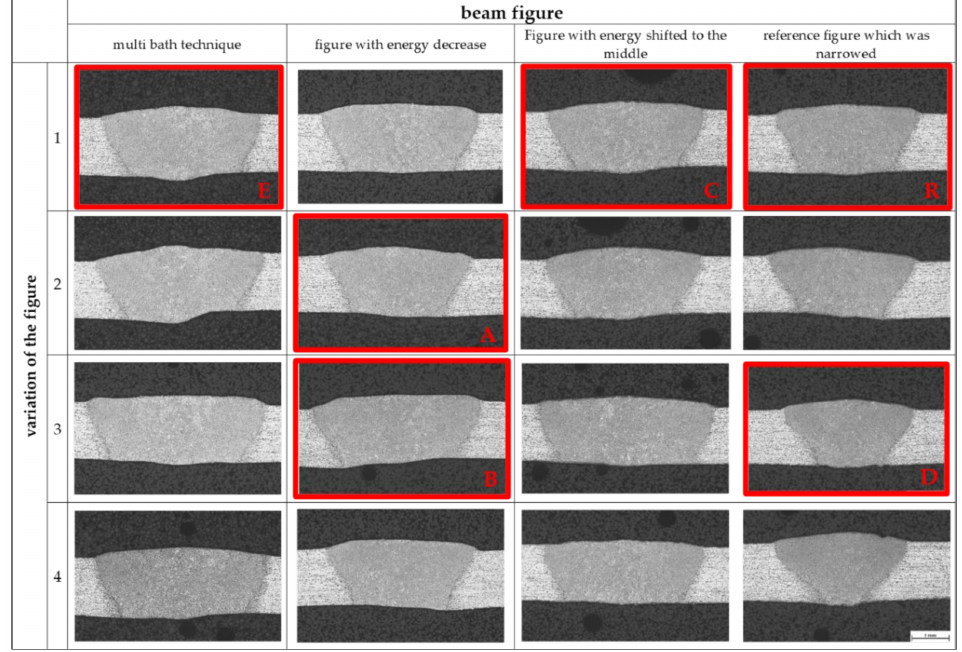
Figure A2. Cross-sections from the first set of experiments. The microstructures outlined in red are the representatives for the second set of experiments and marked like